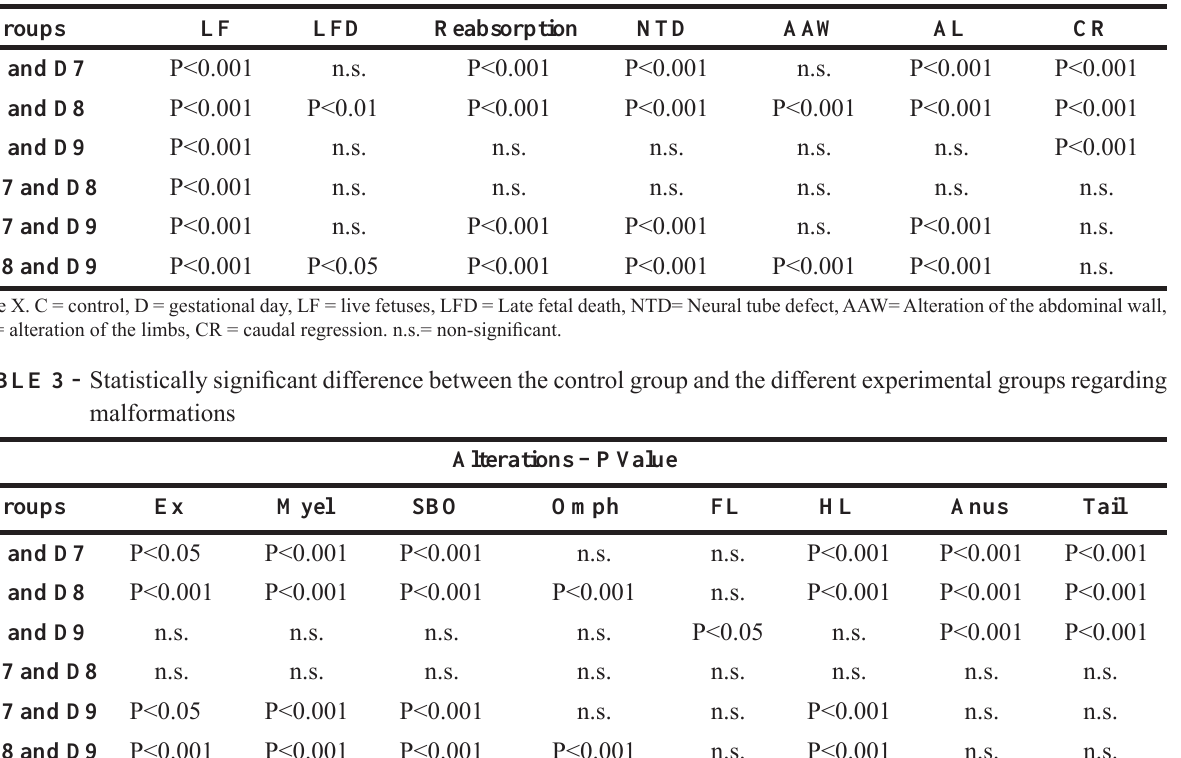
TABLE 2 - Statistically signi fi cant difference between the control group and the different experimental groups regarding the number of live fetuses, late fetal deaths, reabsorptions, and malformations